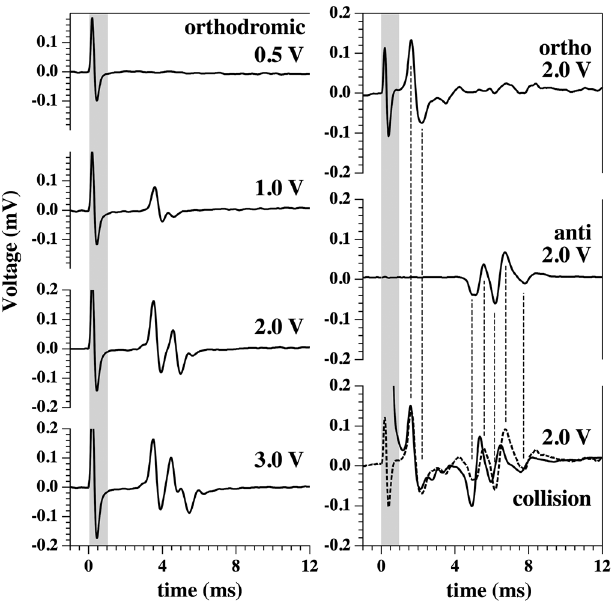
FIG. 10. Same as in Fig. 9 (right) but with higher stimulation voltage (3 V, different preparation). More axons are stimulated, and all giant fibers are active. The bottom trace shows the collision experiment (solid line) compared with the sum of the top (orthodromic) and the center (antidromic) traces. Again, the two traces are virtually superimposable, indicating that no annihilation of any of the signals took